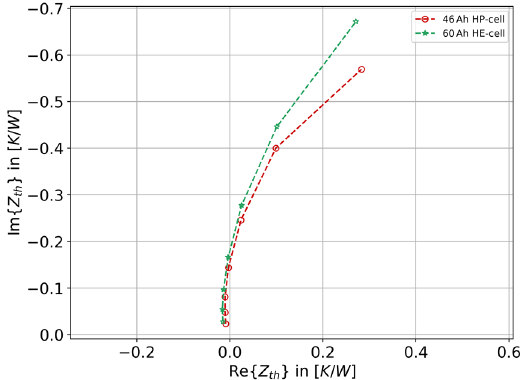
Figure 9. Comparison of the Nyquist plot for different cell types at the same conditions ( T amb = 25 °C, SOC = 50% and I ≙ 2C).